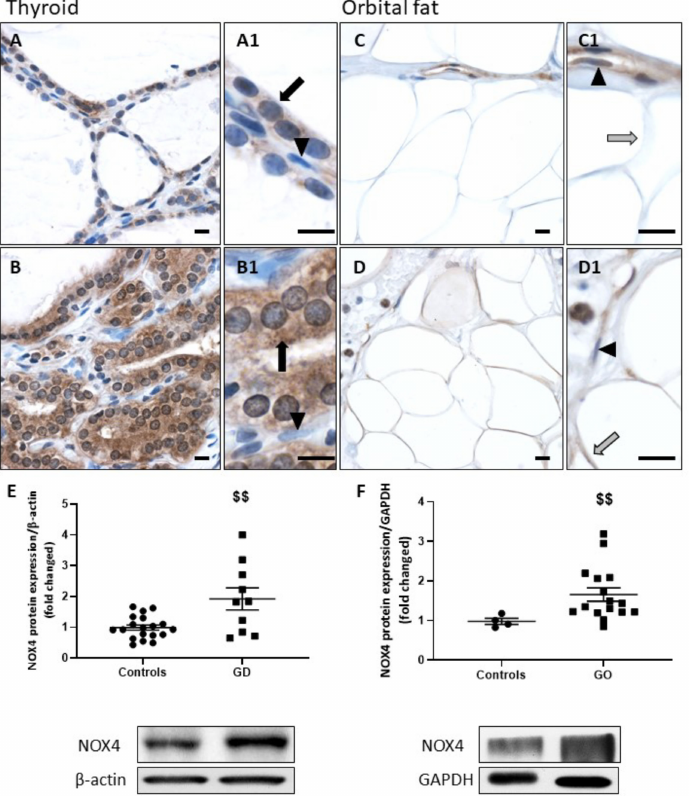
Figure 1. Increase of NOX4 in GD thyroids and GO orbital fats. In GD thyroids, NOX4 ( B ) was highly expressed in the thyrocyte cytoplasm. A weaker signal was detected in the cytoplasm of control thyroid cells ( A ). GO orbital adipocytes ( D ) also showed a higher expression of NOX4 than controls ( C ). A signal of similar intensity was detected in endothelial cells (arrowheads) in both conditions and tissues. ( A1 – D1 ) Thyrocytes are indicated by black arrows, adipocytes by gray arrows, and endothelial cells by arrowheads. Scale bars = 10 µ m. Western blot analysis revealed that NOX4 was significantly increased in GD ( E ) or GO patients ( F ) versus controls. Data represent the mean ± SEM from 19 controls and 10 GD thyroids and from 4 controls and 16 GO orbital fats. $$ p < 0.01 compared to controls. Densitometric values were normalized against β -actin or GAPDH. Western blots shown are representative of both